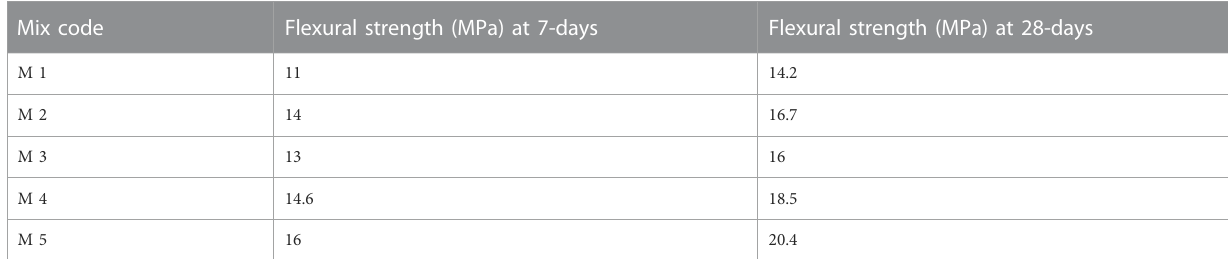
TABLE 9 Flexural strength results.